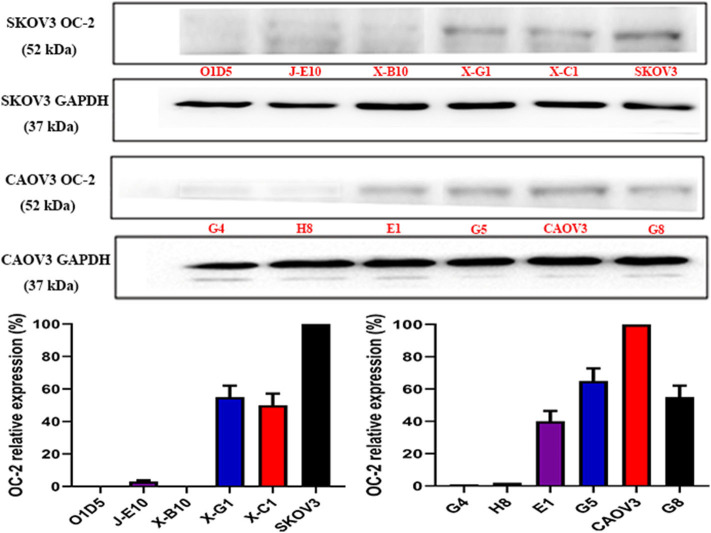
Validation of OC-2 KO in SKOV3 and CAOV3 cells. The expression status of OC-2 was analyzed by Western blotting assay. From left to right, inhibition rates vs. SKOV3 control: O1D5 100%, J-E10 97%, X-B10 100%, X-G1 45%, and X-C1 50%; inhibition rates vs. CAOV3 control: G4 99%, H8 98%, E1 60%, G5 35%, and G8 45%. GAPDH served as loading control. The signal intensities were analyzed by ImageJ software.